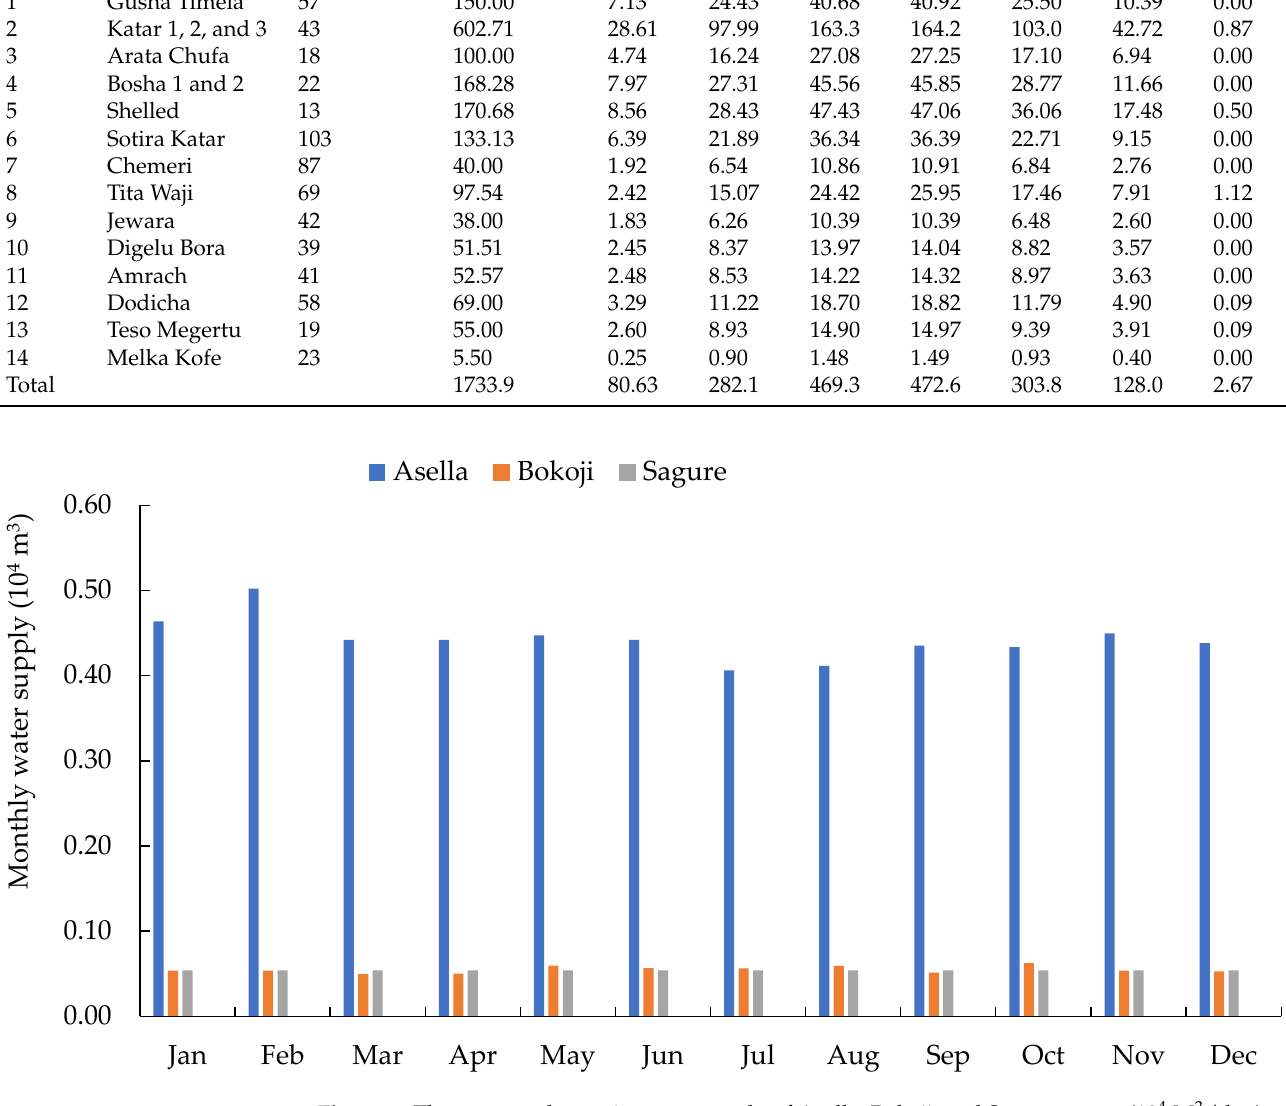
Figure 3. The average domestic water supply of Asella, Bokoji, and Sagure towns (10 4 M 3 /day).